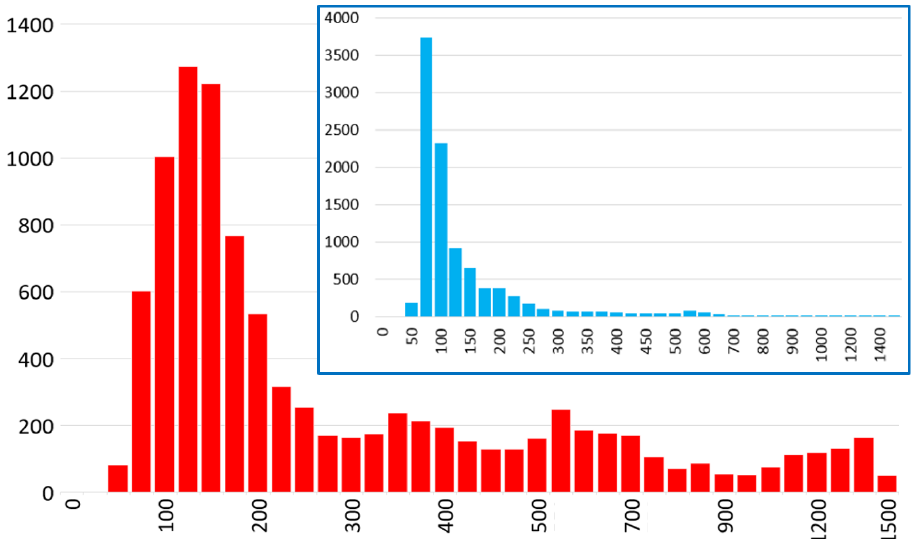
Figure 14. Downlink (red) and uplink (blue) traffic packet size distribution of APN “C” (x axis: number of packets, y axis: Size of flows